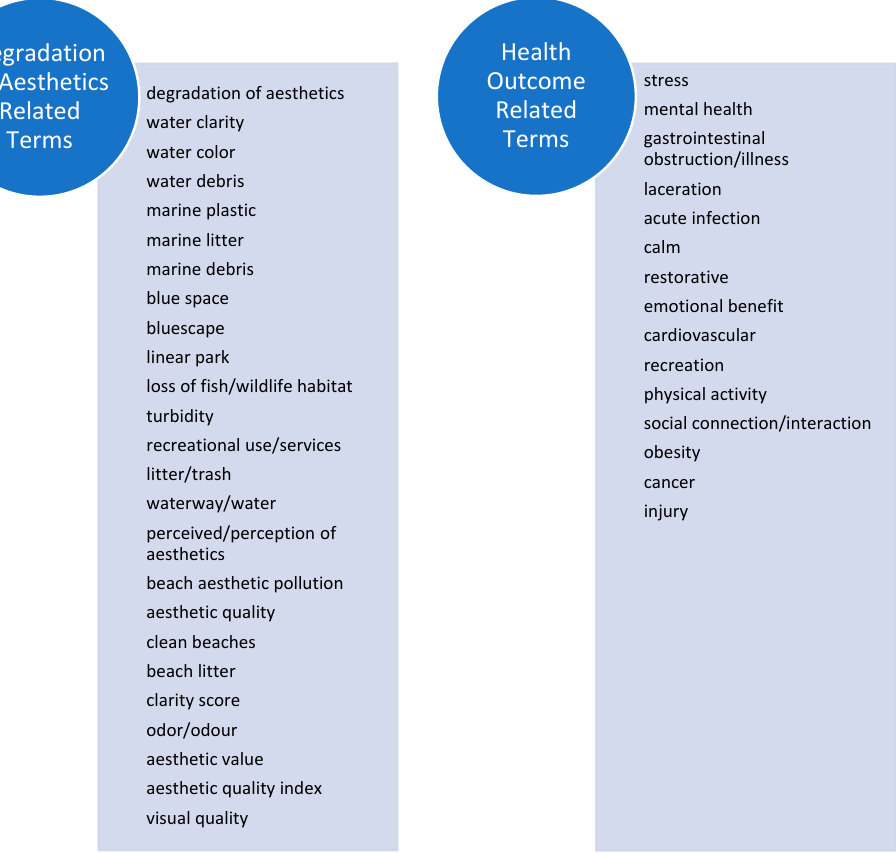
Figure 2. List of search terms, full search strategy and parameters presented in Supplemental Table S1.